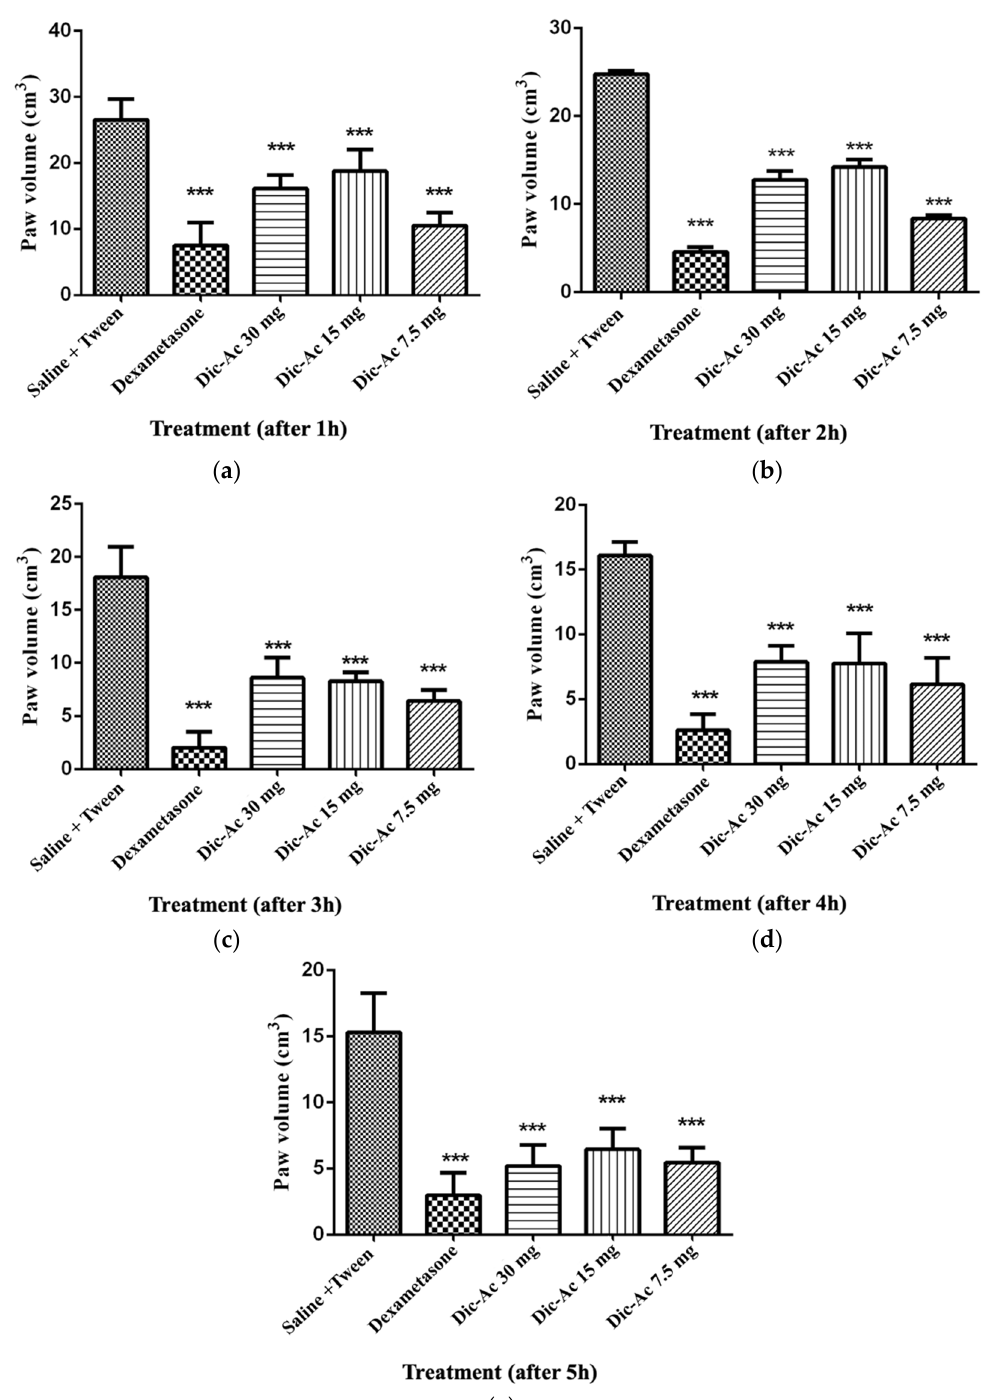
Figure 2. Carrageenan-induced paw edema in mice from the control groups and treated with the Dic-Ac. Increased paw thickness after 1 h of evaluation ( a ), after 2 h of evaluation ( b ), after 3 h of evaluation ( c ), after 4 h of evaluation ( d ), after 5 h of evaluation ( e ). The results are expressed as mean ± SEM of three repetitions. *** p < 0.001. Significant after two-way analysis of variance (ANOVA) followed by the Bonferroni test with a 95% confidence interval, when compared to the control